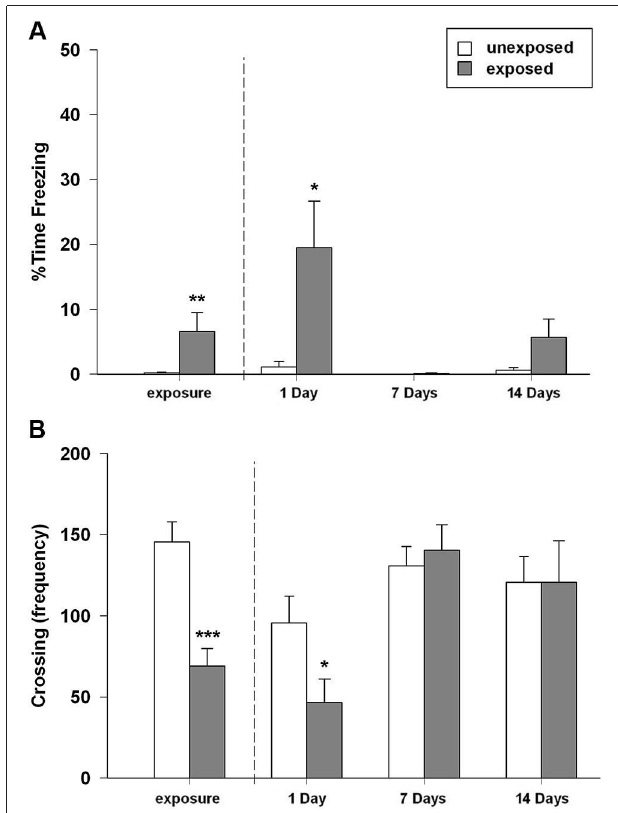
FIGURE 2 | (A) Percentage of time spent in freezing and (B) number of crossings of rats exposed to an unworn (unexposed) or to a worn (exposed) cat collar during the exposure session (left plot) (EXP, UNEXP: n = 12) and re-exposure sessions performed 1, 7, or 14 days after the exposure to the stressor (right plots) (1D EXP n = 8, UNEXP n = 7; 7D EXP, UNEXP n = 9; 14D EXP n = 9, UNEXP n = 8). Data are expressed as mean + SEM (* p < 0.05; ** p < 0.01; *** p < 0.001; EXP vs.